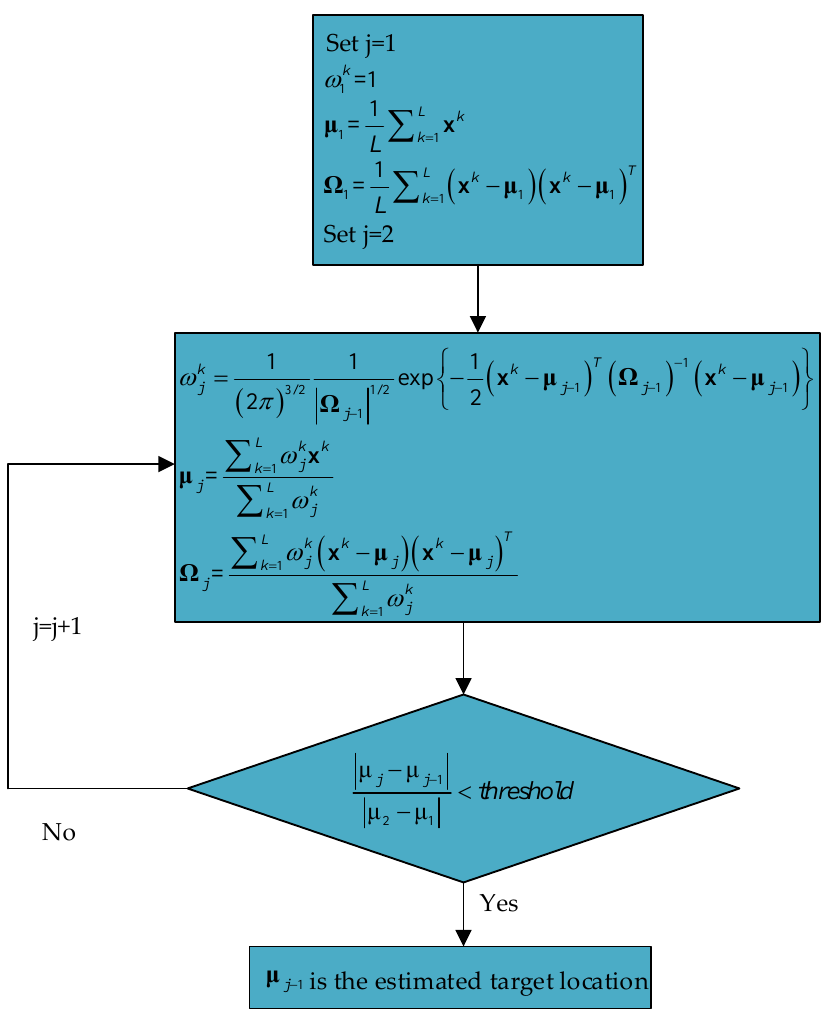
Figure 7. The flow chart of the Iterative Maximum Weighted Likelihood Estimation (IMWLE) method. The pseudo-targets, whose coordinates are denoted by vector x k , are assigned weight factors ω k j . Superscript k refers to the pseudo-target location numbers. Subscript j refers to the iteration